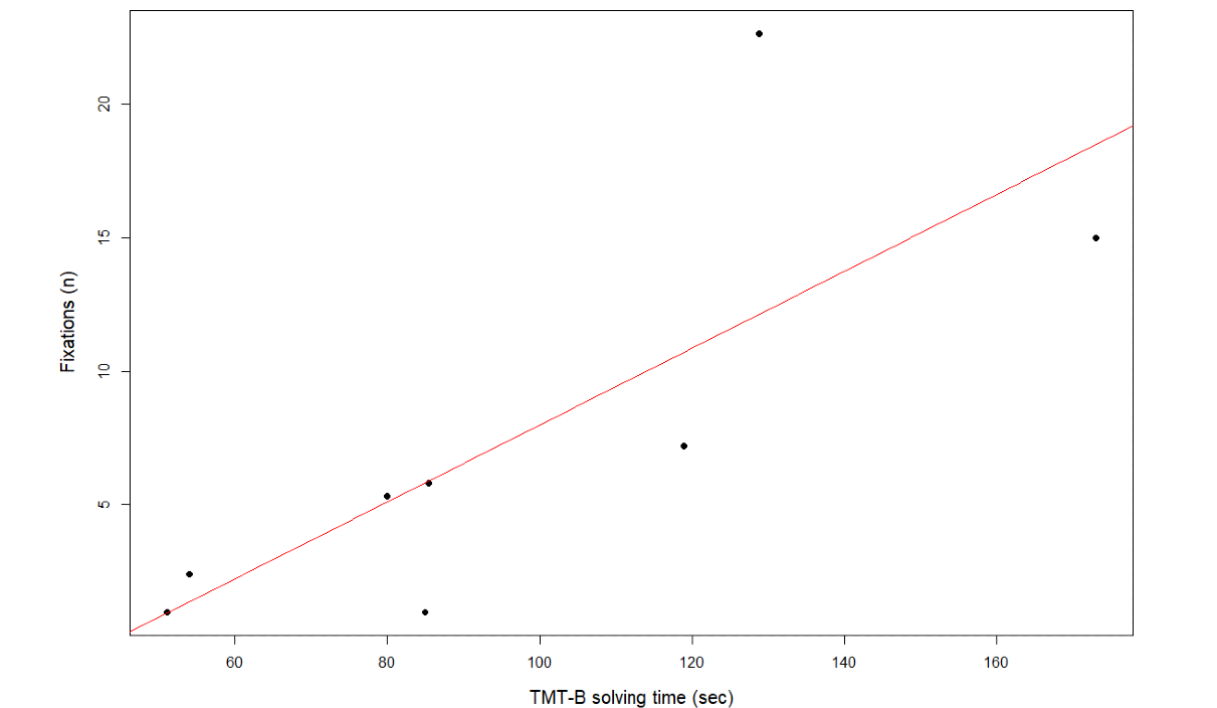
Figure 5. Correlation between average number of fixations and Trail Making Test B solving